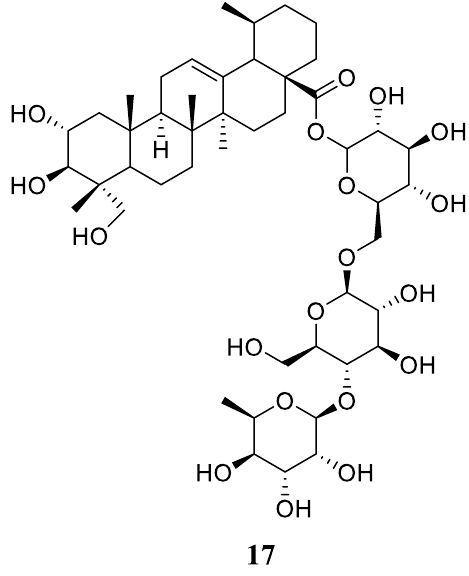
Figure 6. Chemical structures of asiaticoside ( 17 )